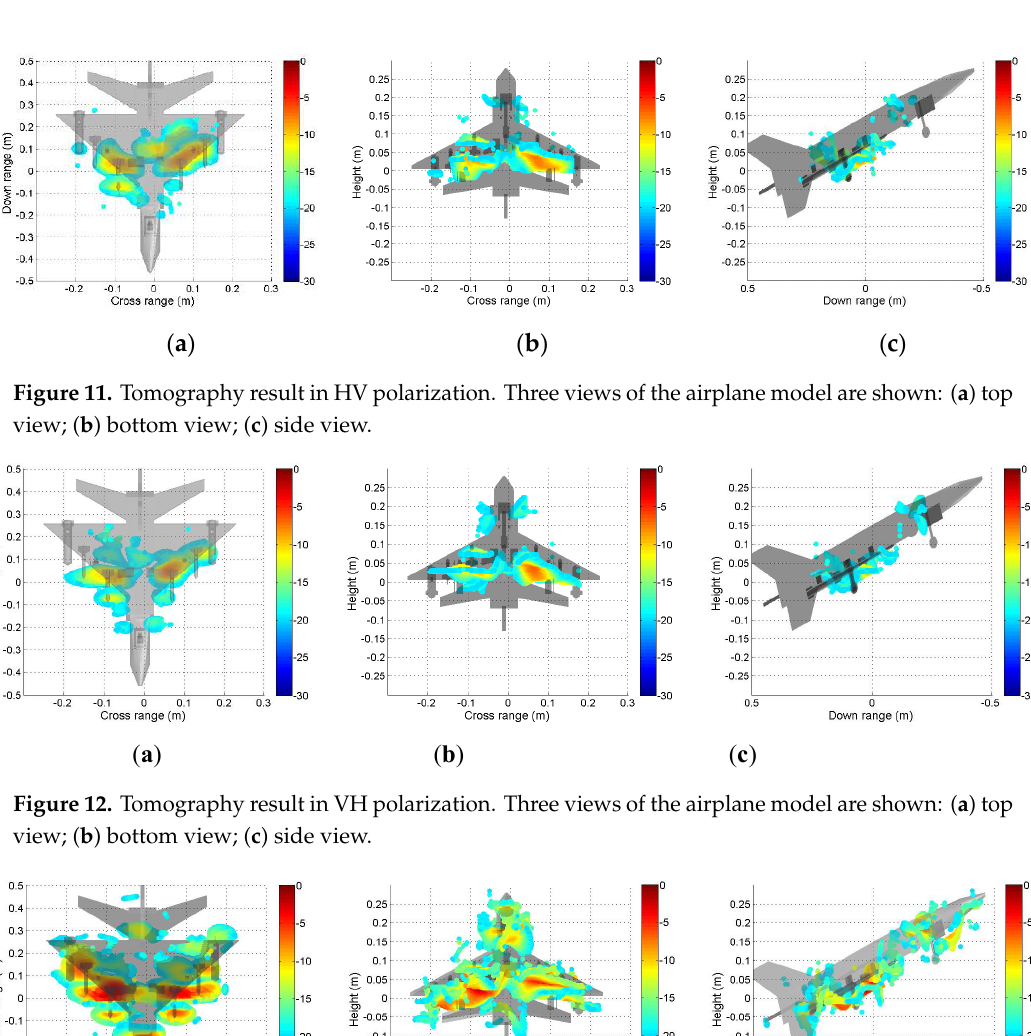
Figure 10. Tomography results in HH polarization. Three views of the airplane model are shown: ( a ) top view; ( b ) bottom view; ( c ) side view.